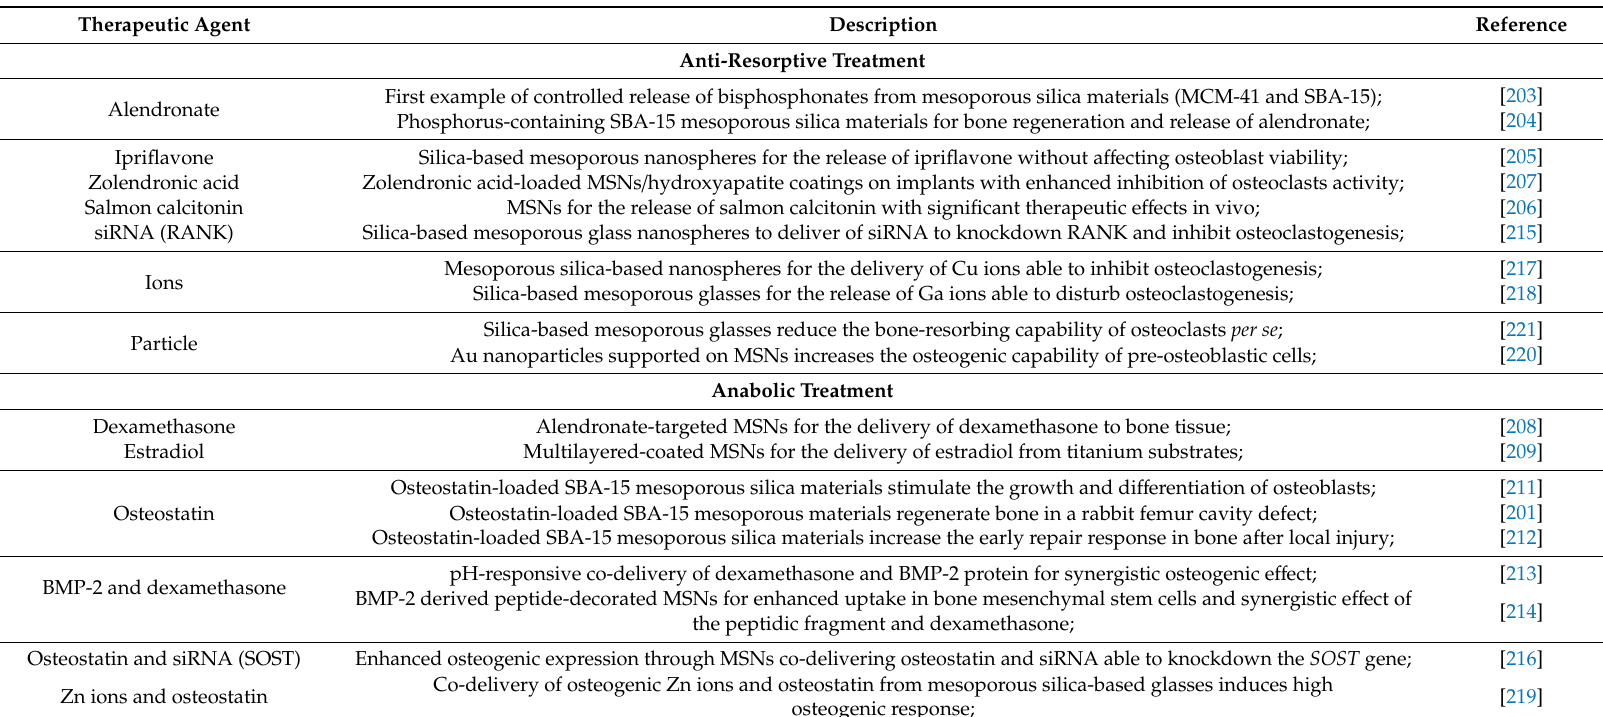
Table 3. Summary of silica-based mesoporous materials for the treatment of